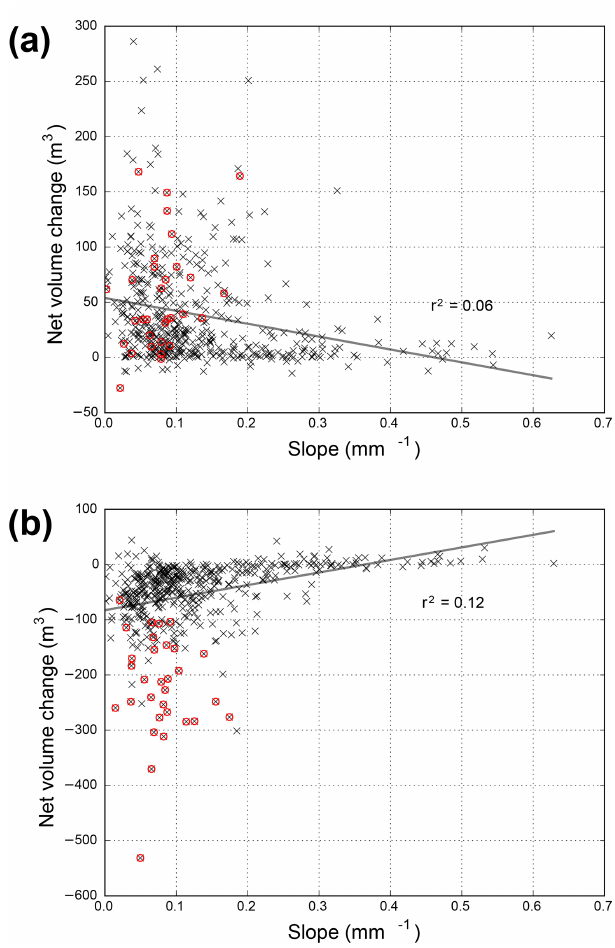
Figure 12. Scatterplot of Hill Gulch for net volume change versus slope for (a) T1 and (b) T2. Red circles correspond to the segments highlighted in Fig.